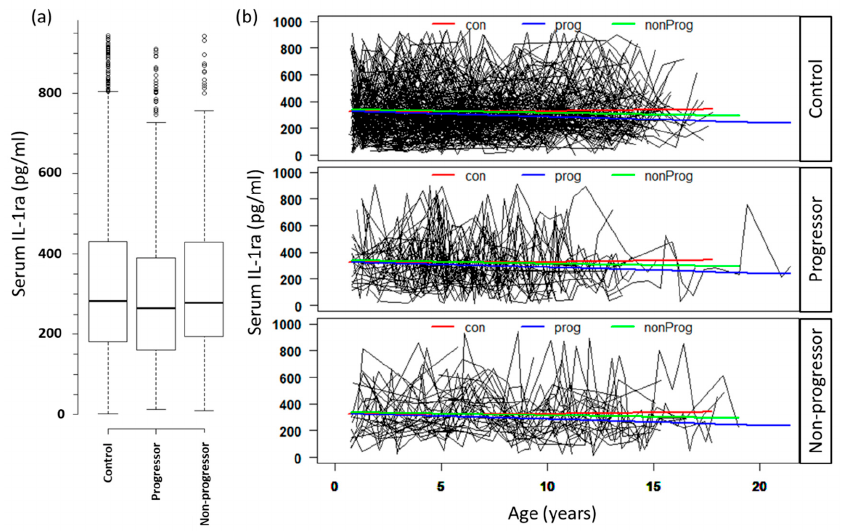
Figure 1. Distribution of IL-1ra levels in three groups. ( a ) Boxplot showing differences in serum level of IL-1ra in three groups in the study. ( b ) Spaghetti plots showing IL-1ra level in serum over age in subjects from three groups. IL-1ra levels were measured in longitudinally collected samples over time. Average number of samples per subjects was 9 with a range of 3 to 28 samples. Serum IL-1ra level (pg/mL, y -axis) is plotted against the age of collection of sample ( x -axis). A smooth spline was plotted for con: controls (red line); prog: progressor (blue line); and nonProg: non-progressor (green line). The progressor group shows a decline in serum IL-1ra from the start and decreased markedly as the age progresses.